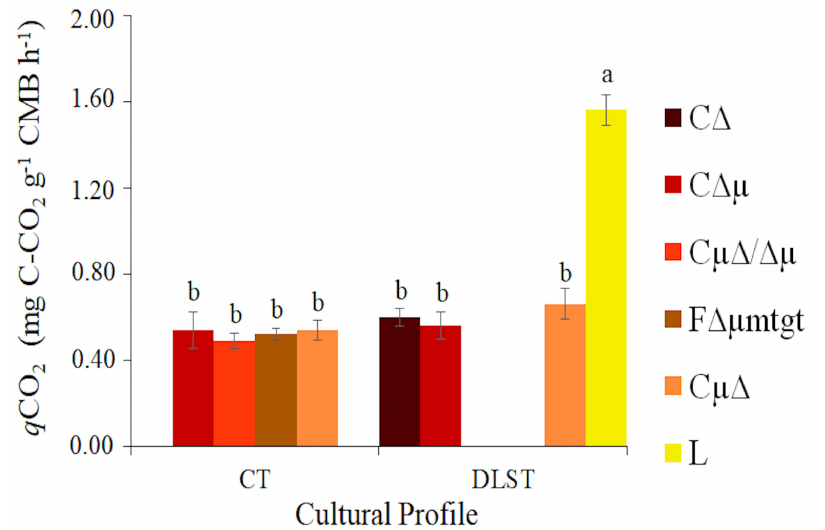
Figure 8. Metabolic quotient (qCO2) in a dystrophic Red-Yellow Latosol under conventional tillage (CT) and deep localized soil tillage (DLST). Organization of clods: L = free soil volume, C = continuous soil volume, F = cracked soil volume, NAM = unaltered soil volume by soil use and management, mt = medium clods (7 cm Ø), gt = large clods (10 cm Ø). Internal states of clods: μΔ = porous with indications of compression, μΔ/Δμ = medium porosity, Δμ = compact with some porosity, Δ = compact with no visible porosity to the naked eye. Bars indicate the mean standard error. Volumes of soil with the same letter for different soil tillage systems did not differ statistically in Tukey’s test (p ≤